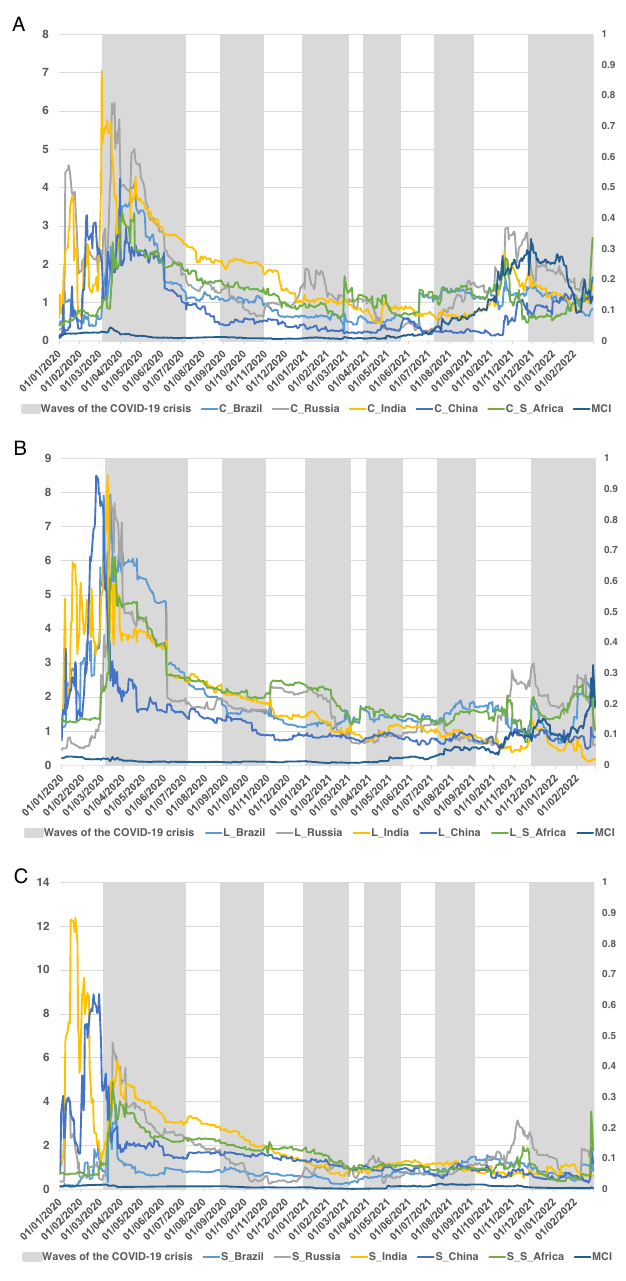
Fig. 3 Dynamic contribution FROM the system of the three components of BRICS term structure. Figure collects the timevarying connectedness FROM measure between the BRICS term structure of interest rates (decomposing into level ( A ), slope ( B ), and curvature ( C )) using the TVP- VAR framework (Antonakakis and Gabauer, 2017), during the waves of the COVID-19 pandemic